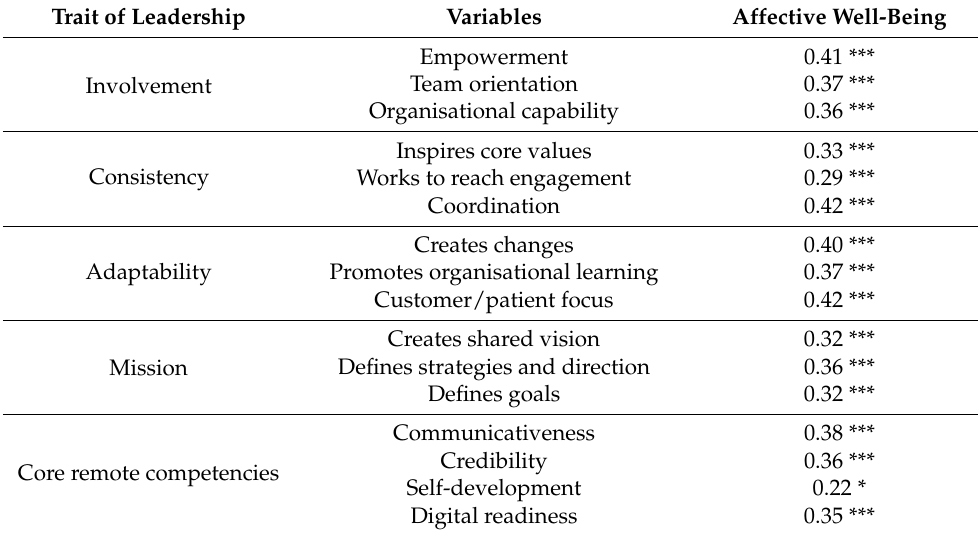
Table 3. Spearman’s correlations between all leadership strategies, core remote competencies and affective